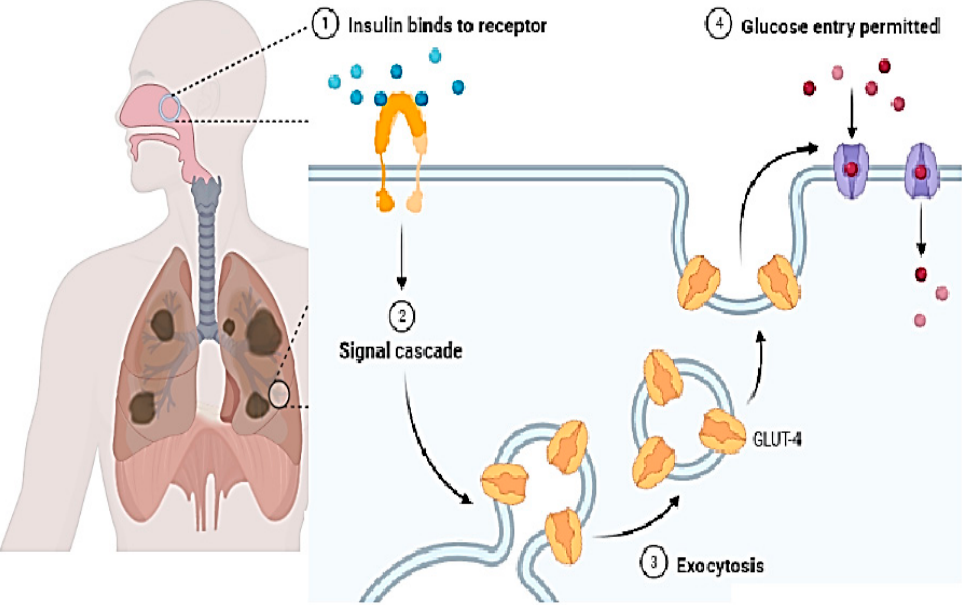
Figure 11. Inhalation of vaccine through the nasal cavity, and its mechanism inside the body in immune cells immune cells [103,105,106].